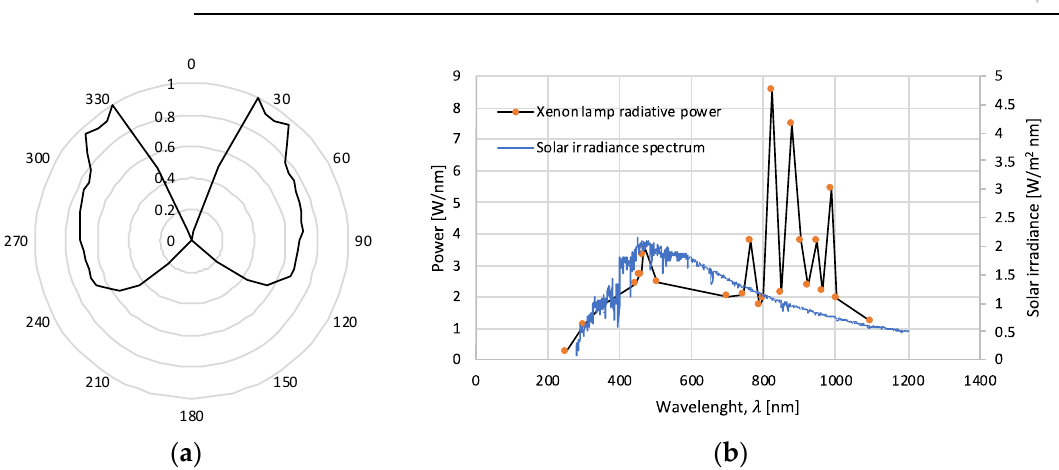
Figure 6. Characteristics of OSRAM XBO 4000 W/HSA OFR Xenon short arc lamp: ( a ) photometric solid; ( b ) comparison between spectral distribution of the radiative emissive power ( Q λ ) [7] and solar spectrum.